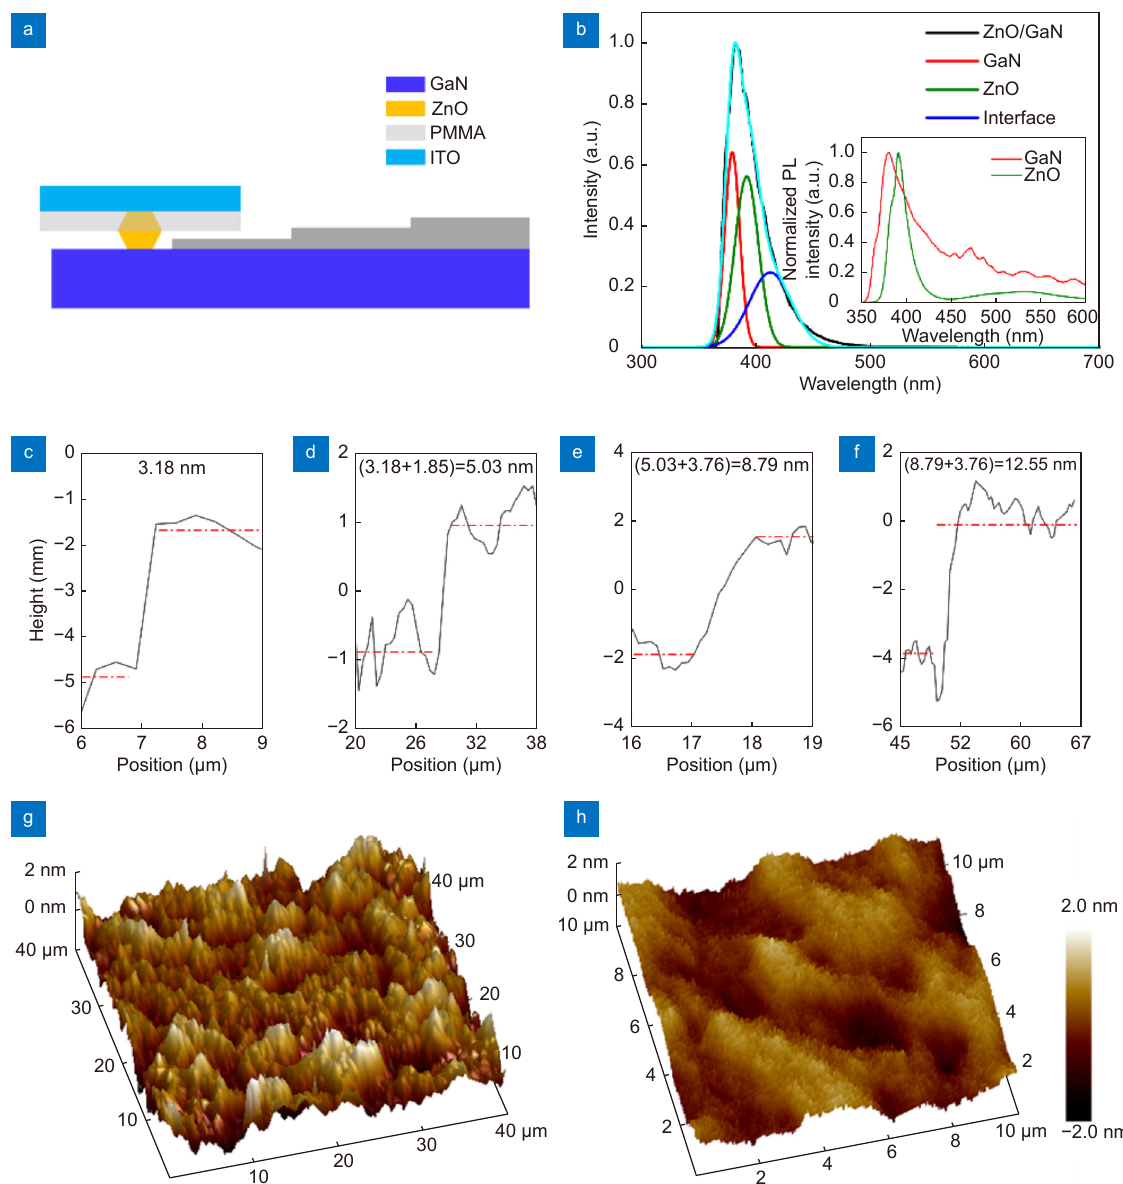
Fig. 2 | ( a ) A schematic diagram for ZnO/GaN LEDs. ( b ) The Gaussian decomposition of EL spectra for LED and the inset depicts the PL spec- tra of the GaN film as well as ZnO MWs. ( c−f ) The height of the step-like HfO 2 film with different sputtering time (c) 2 min, (d) 3 min, (e) 5 min and (f) 7 min. ( g , h ) AFM image for the GaN surface (g) before and (h) after bonding HfO 2 film with thickness of 5.03